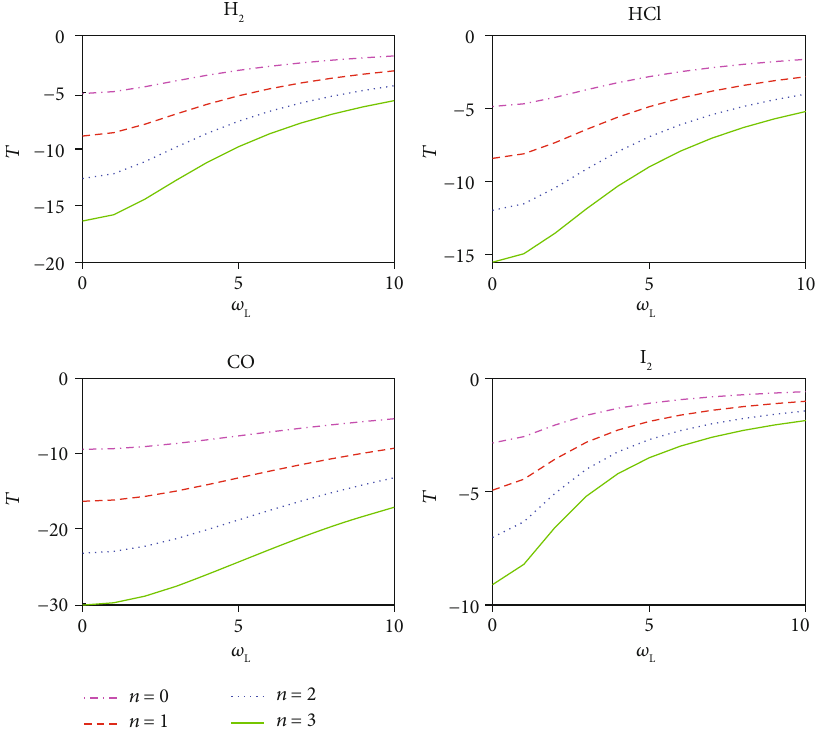
Figure 2: The expectation value of the square of the momentum p 2 as a function of Larmor frequencies ω and I ) and for various numbers of states n with g = m = 1 2